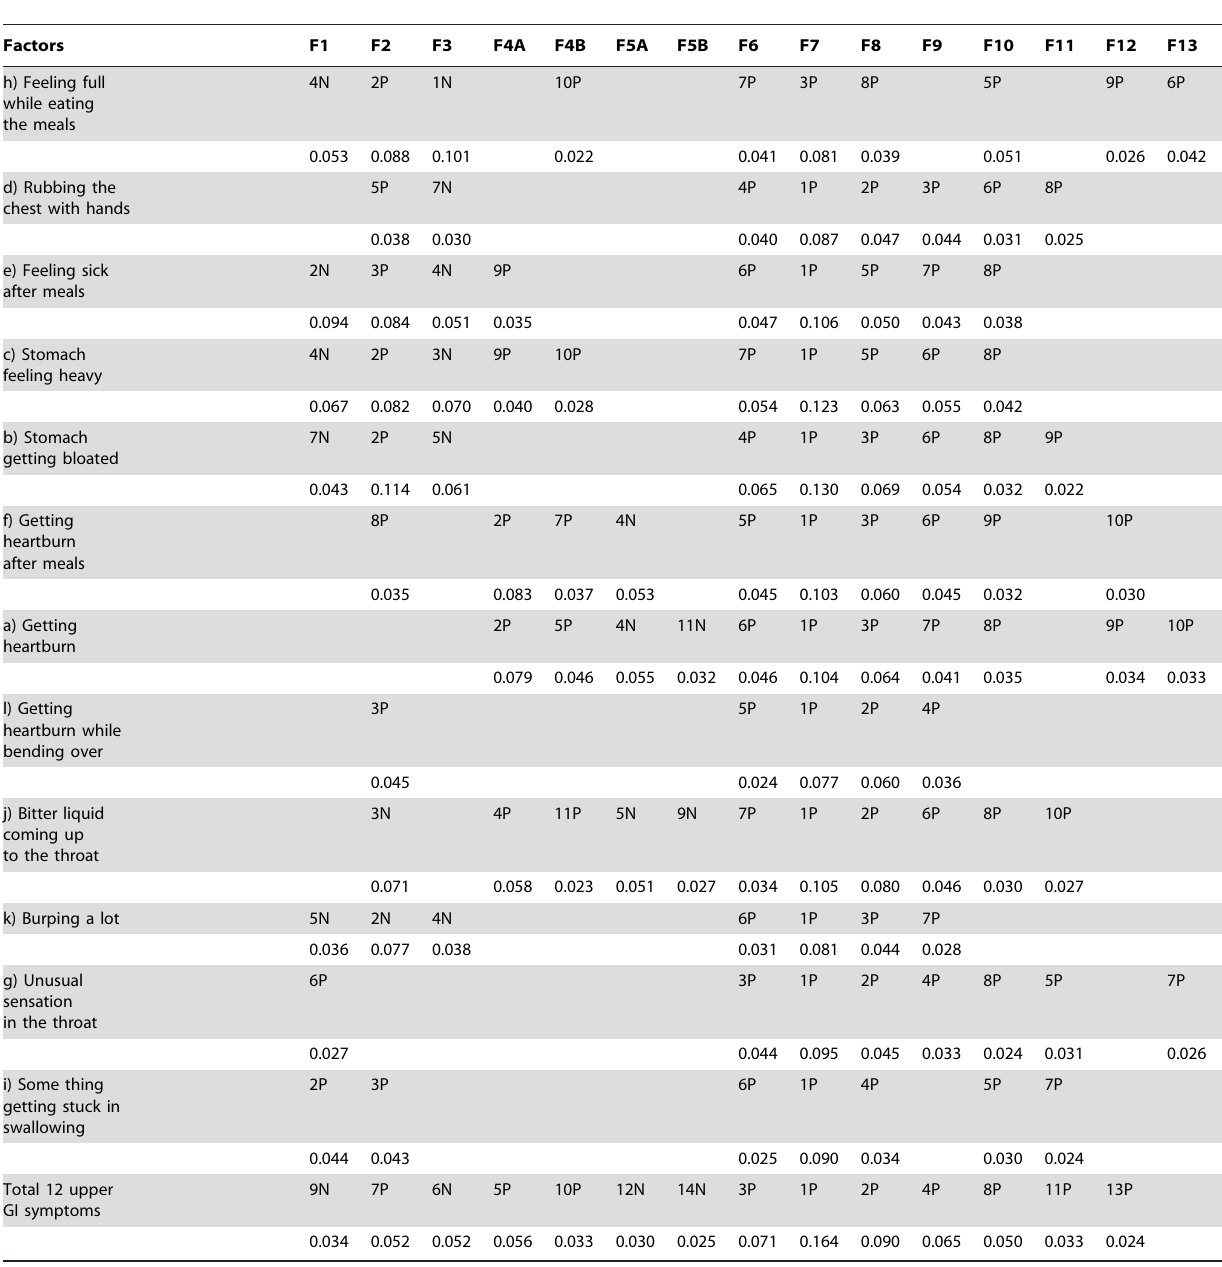
Table 2. Orders, directions, and standardized coefficients of association between the 12 upper GI symptoms and 13 background factors among the 18,097 digestive drug-free